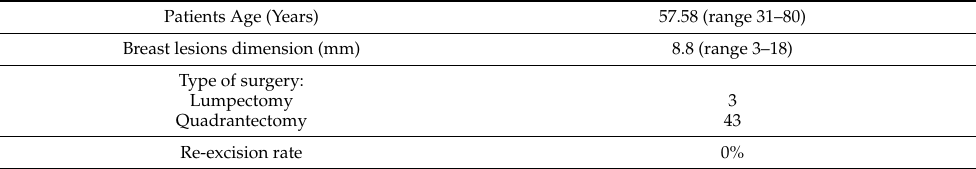
Table 1. Clinical and surgical data. Millimeters (mm). Ductal carcinoma in situ (DCIS). Invasive ductal carcinoma (IDC). B3 lesions according to the lexicon BI-RADS ®